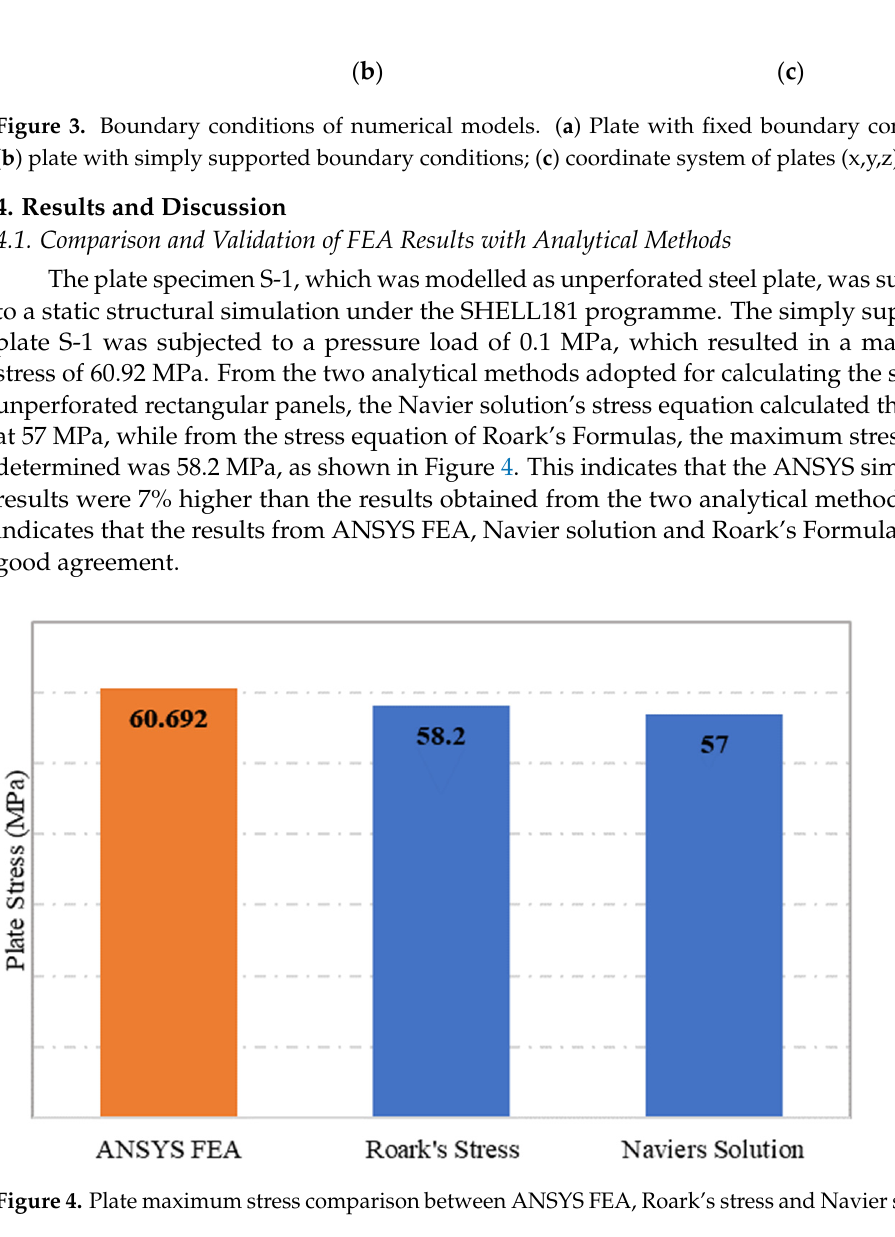
Figure 3. Boundary conditions of numerical models. ( a ) Plate with fixed boundary conditions; ( b ) plate with simply supported boundary conditions; ( c ) coordinate system of plates (x,y,z).